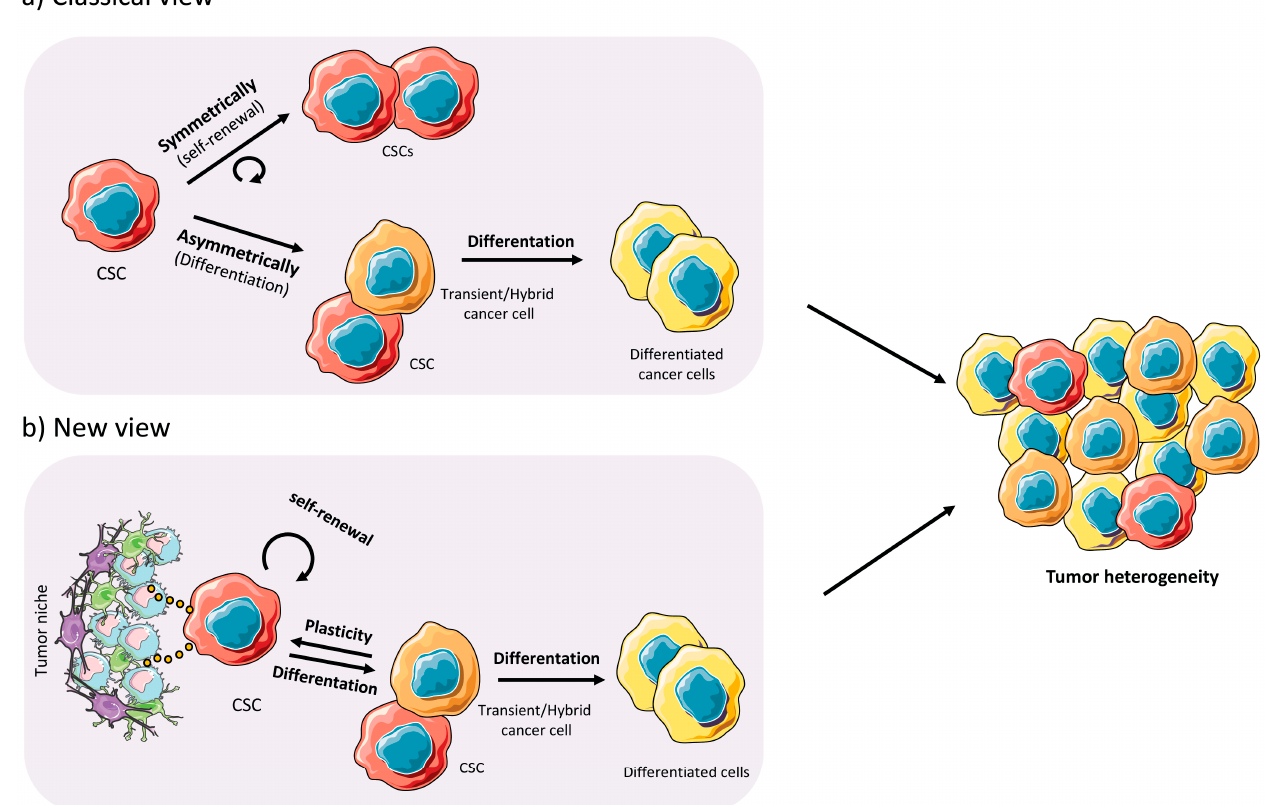
Figure 2. Models of the cancer stem cell concept to explain tumor heterogeneity. ( a ) Classical view shows the two pathways of Cancer Stem Cells (CSCs) differentiation: symmetrically (self-renewal) resulting in two CSCs and asymmetrically (differentiation) giving rise to a CSCs and a transient/hybrid cancer cell that gives rise to the more differentiated cells. These more differentiated cells divide rapidly and have less tumorigenic potential and plasticity compared to CSCs or transient/hybrid cancer cells. ( b ) Nowadays, this classical model has undergone some modifications. CSCs receive necessary signals from the tumor niche/tumor microenvironment (TME) modulating the path taken for their division. Due to the plasticity of the transient/hybrid daughter cells, they can also undergo reprogramming into a CSC via signals received from the tumor niche/TME. In addition, transient/hybrid cells can also give rise to differentiated bulk cancer cells.